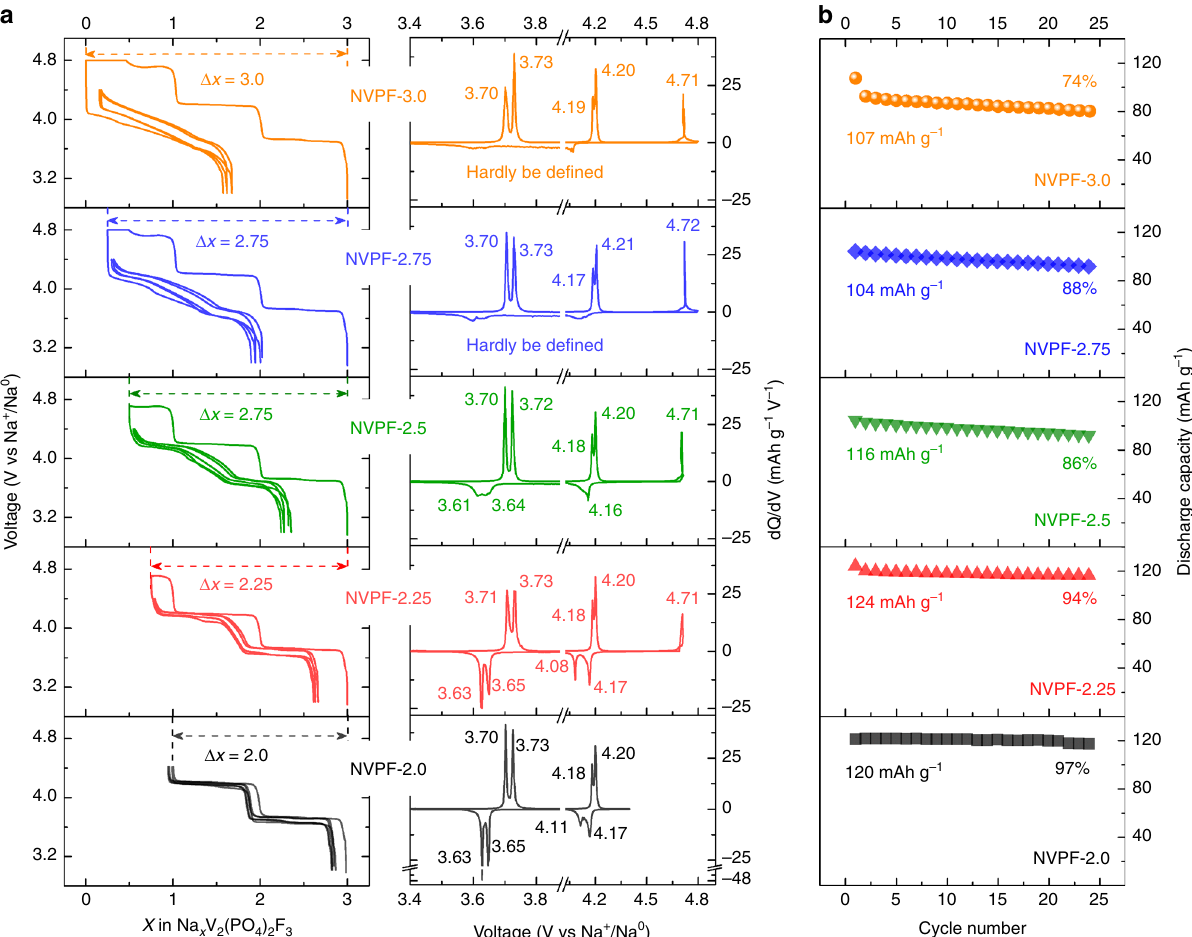
Fig. 1 Electrochemical characterization of NVPF samples in NVPF/Na half cells at a current of C/10 and cycled between 4.4 and 3.0 V. The fi rst charge process alone is controlled by limiting the amount of Na + extracted ( Δ x = 2.0, 2.25, 2.50, 2.75, and 3.0). a Voltage-composition curves (left) and their corresponding d Q /d V curves (right). b The corresponding capacity retention